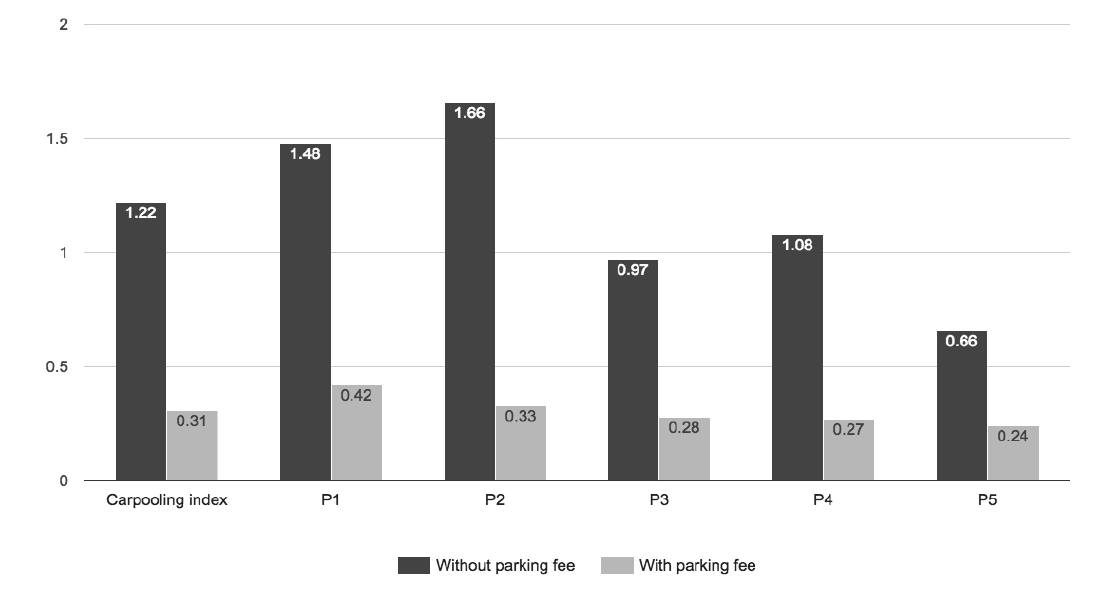
Figure 12. Comparison of the index value and individual costs ratio C r with and without the parking